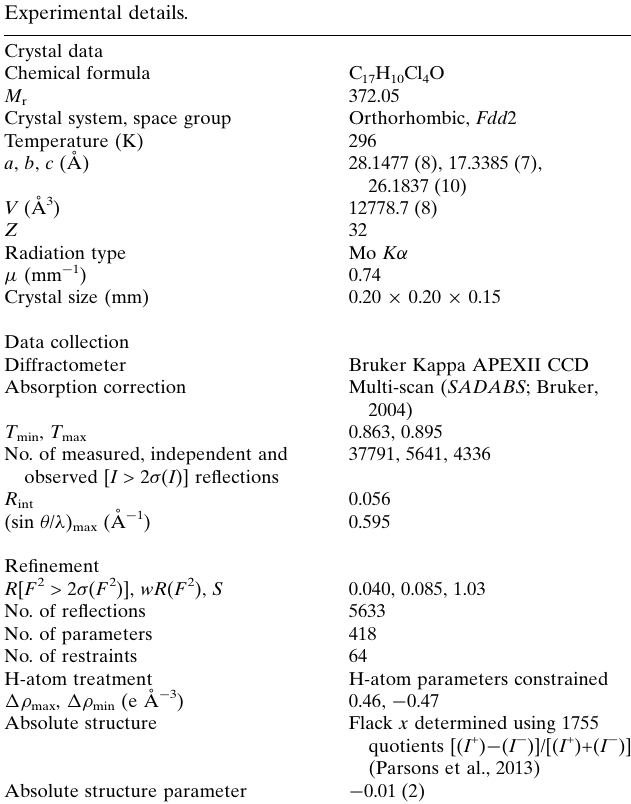
Table 2 Experimental details.